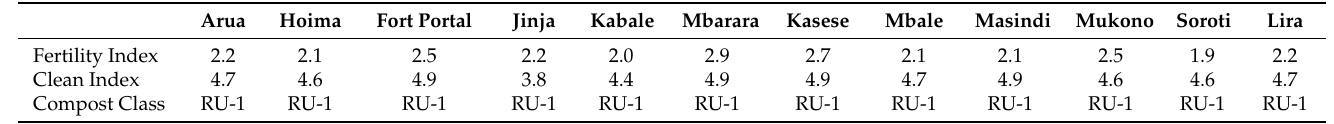
Table 3. Quality control indices and their respective classes for MSWC generated from the 12 CDM compost plants in